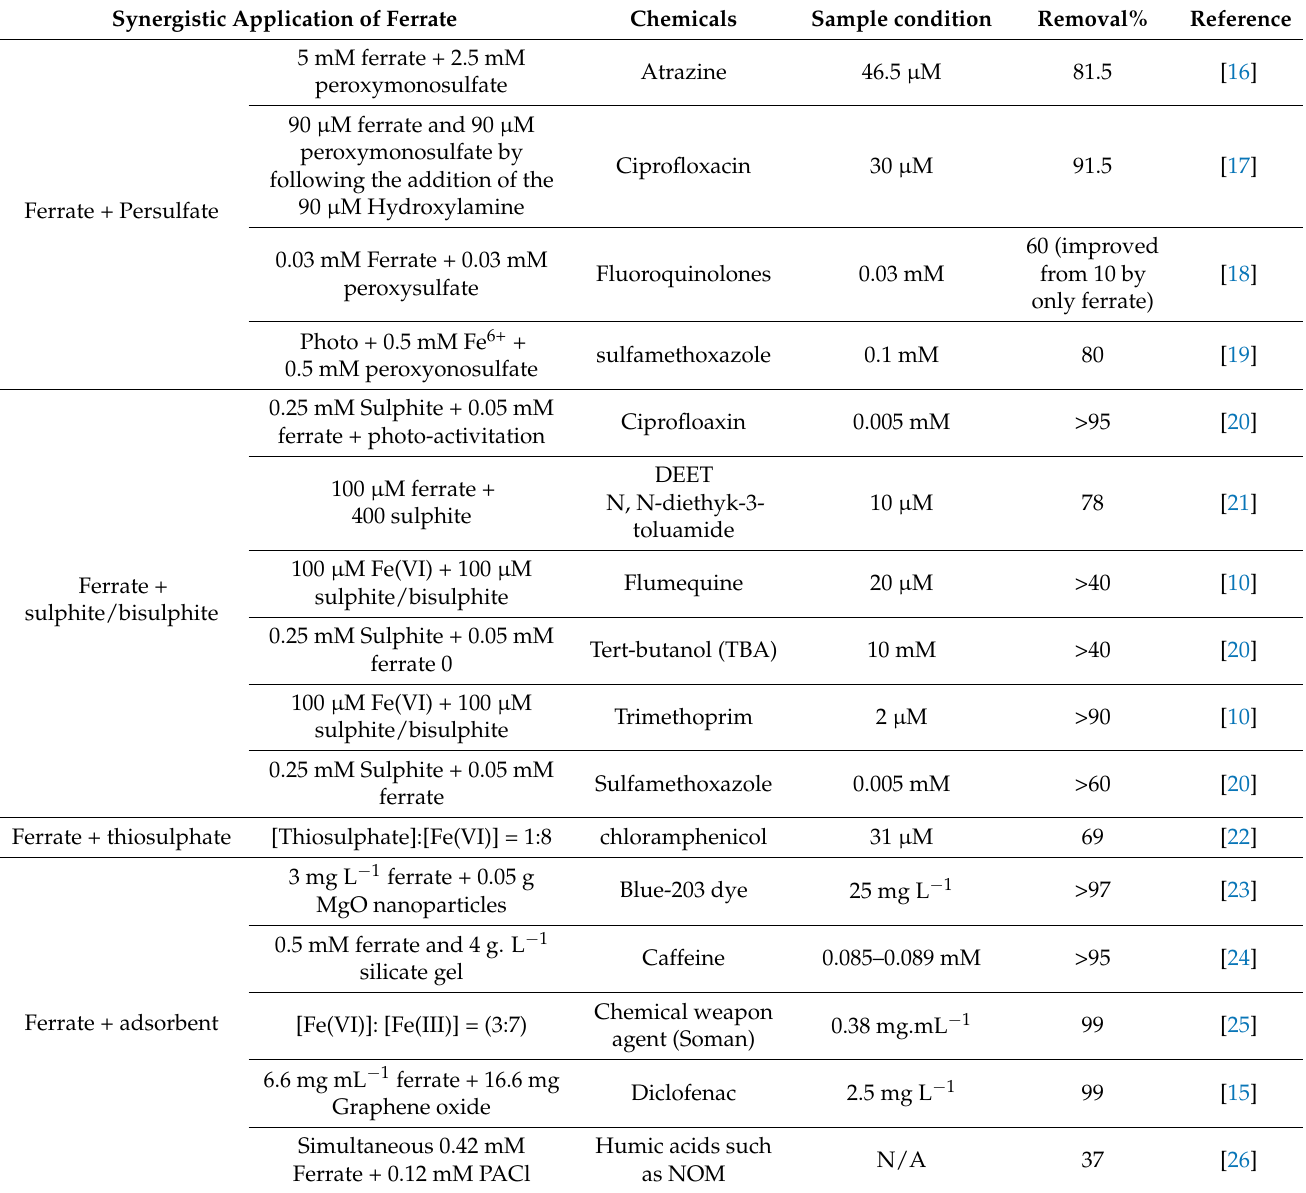
Table 1. Case studies of removing emerging micro-pollutants (EMPs) through synergising ferrate with other